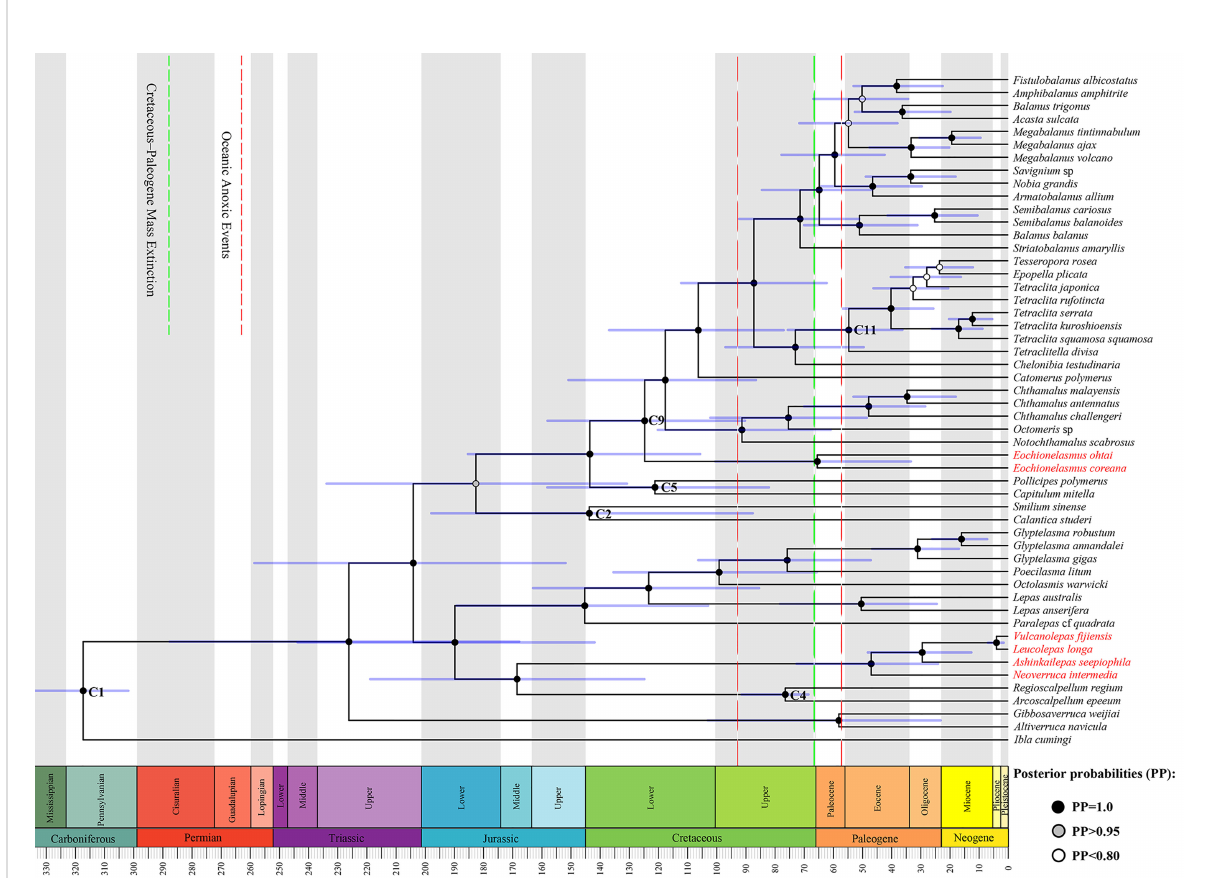
FIGURE 4 Maximum clade credibility time-scaled tree generated under the birth-death model based on the partitioned protein coding genes of barnacle mitogenomes. Fossil calibration points (C1, 2, 4, 5, 9, and 11) follow those used by Pe ́ rez-Losada et al. (2008) and Herrera et al., (2015). Species highlighted in red belong to the two chemosynthetic barnacle